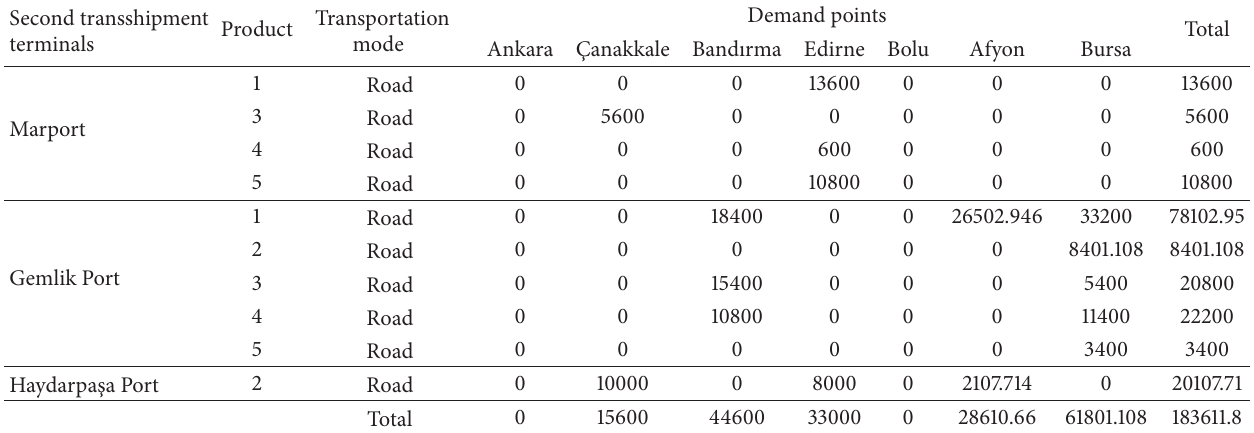
Table 25: Transportation quantities from the second transshipment terminals to demand points.